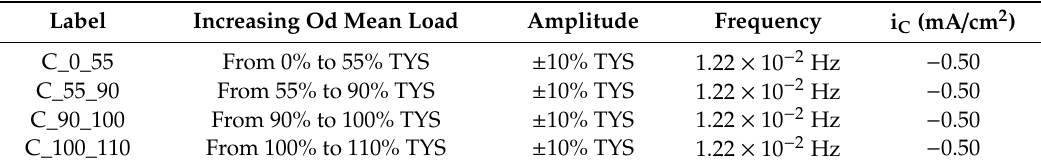
Table 3. Test conditions for the evaluation of the e ff ect of the increasing of the mean load on the hydrogen stationary permeation flux and the passivity